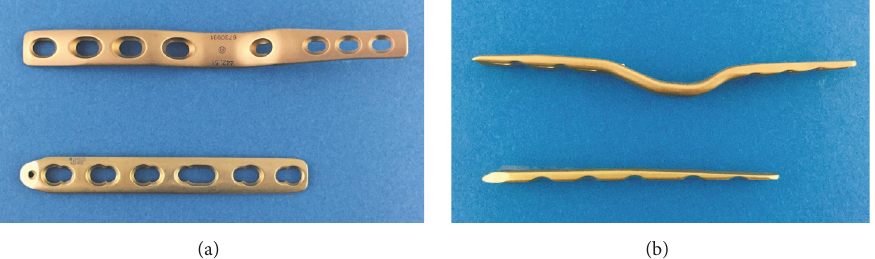
Figure 1: Photographs showing the AO wrist fusion plate with a short bend and the LCP metaphyseal plate 3.5 from top view (a) and side view (b).